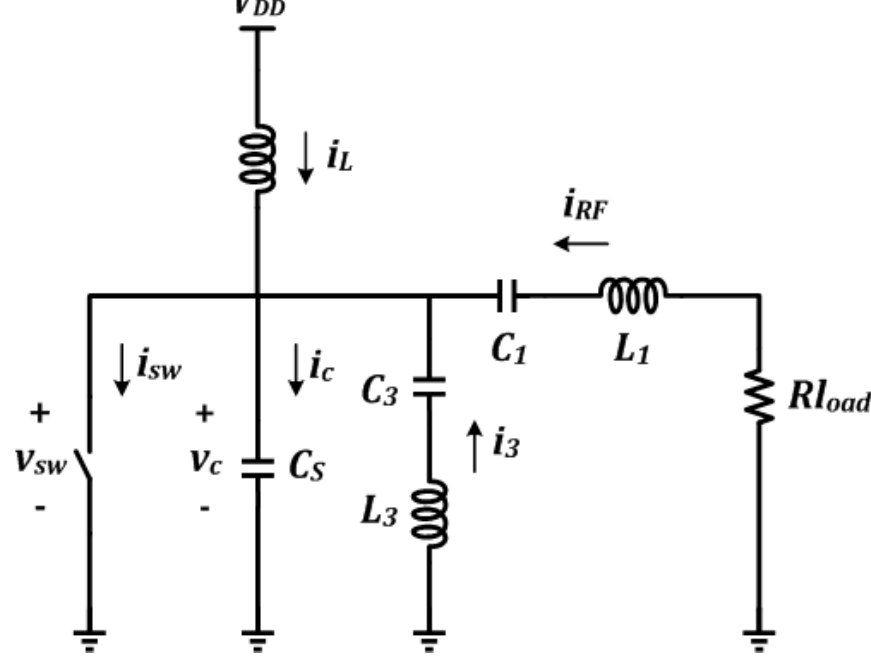
Figure 2. Basic configuration of the third harmonic tuning circuit.